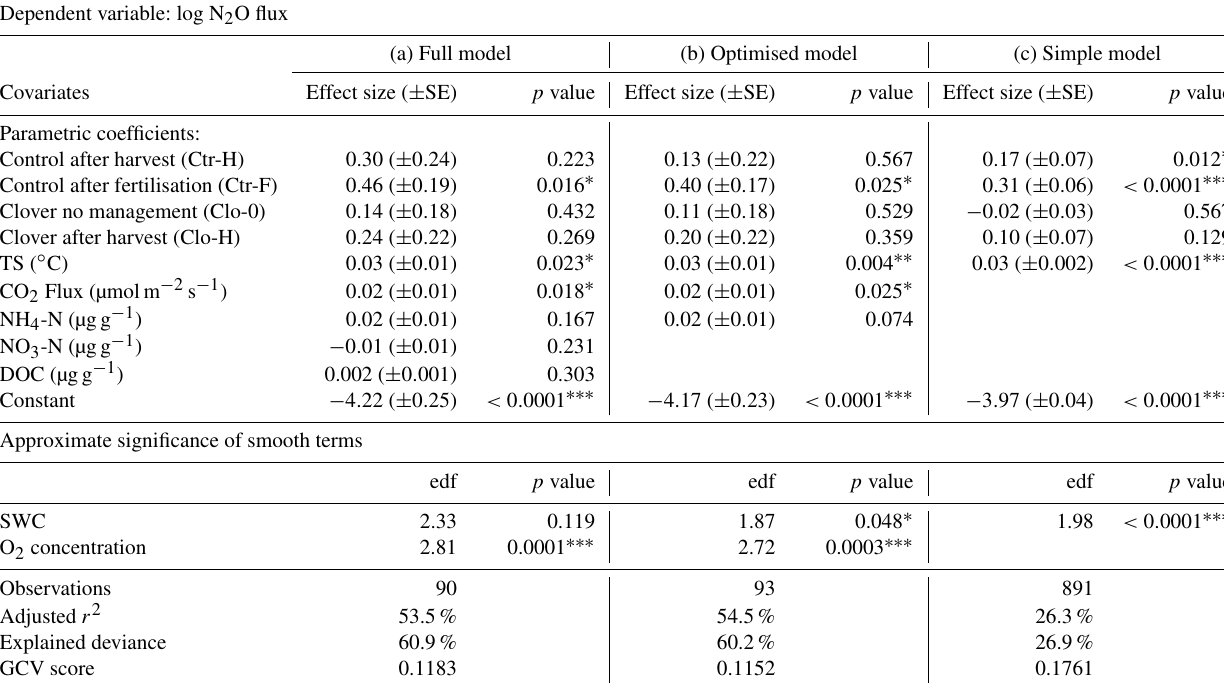
Table 4. Results of generalised additive models (GAMs) (a) including all variables (full model), (b) reduced after stepwise backward elimi- nation, dismissing DOC and nitrate (optimised model), and (c) simplified including only management, soil temperature (TS), and volumetric soil water content (SWC). The control parcel without recent management (Ctr-0) was used as the reference level for the categorical variable management, and thus the constant represents predictions for Ctr-0 and the effect sizes of all other management categories depict differences compared to Ctr-0. The effect sizes are displayed with their standard errors and p values for all linear terms. For the non-linear terms soil water content and oxygen concentration, the respective empirical degrees of freedom (edf) and p values are shown. The effect sizes are direct model outputs, while the values used in the text were back-transformed to increase